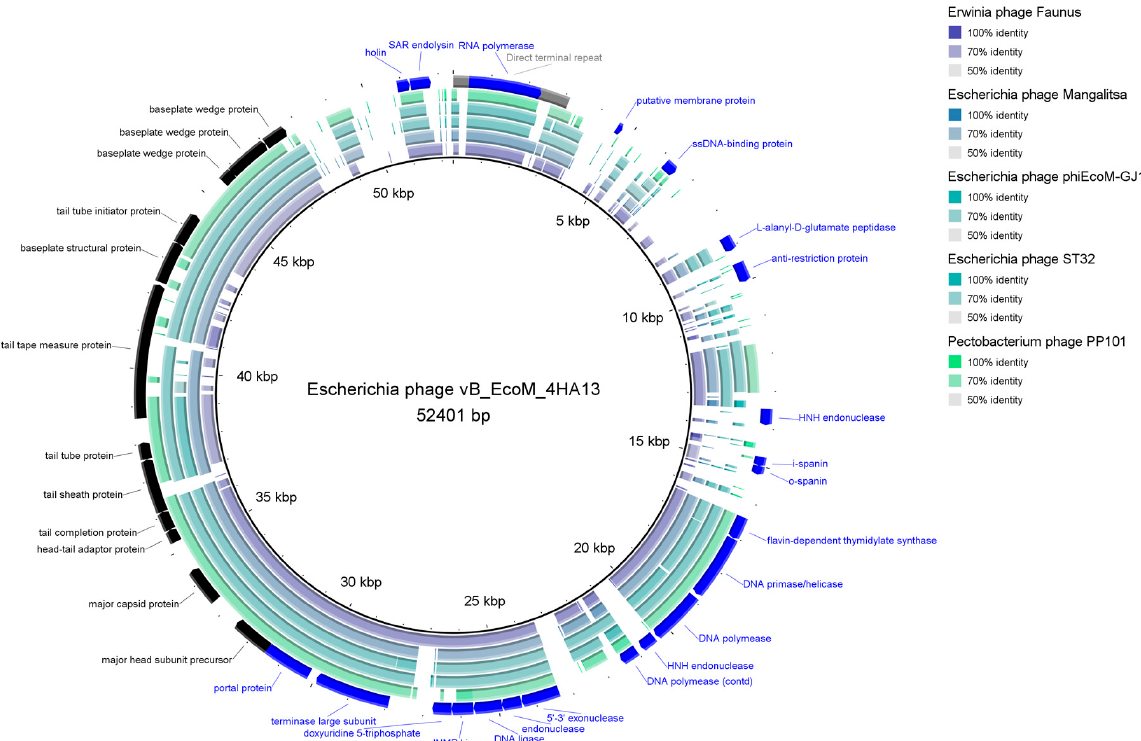
Figure 4. Genome map of 4HA13 and its five closest nucleotide homologues. CDS with annotated functions are highlighted, with structural proteins in black and orientation denoted by arrow-ends. The direct terminal repeat region (3120 bp) is highlighted in grey. The intensity of color of the homologues corresponds to level of nucleotide similarity.